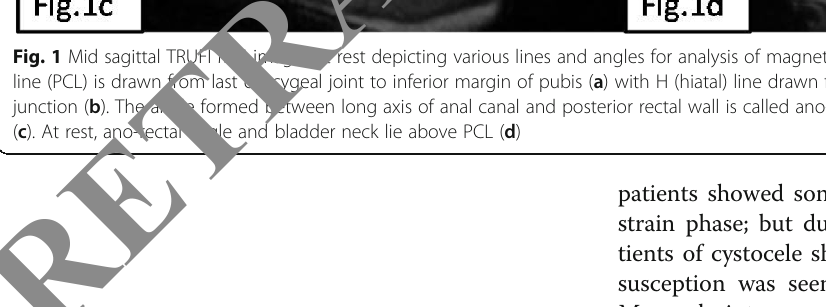
Table 1 Grading of various pathologies Pathology Mild (cm) Severe